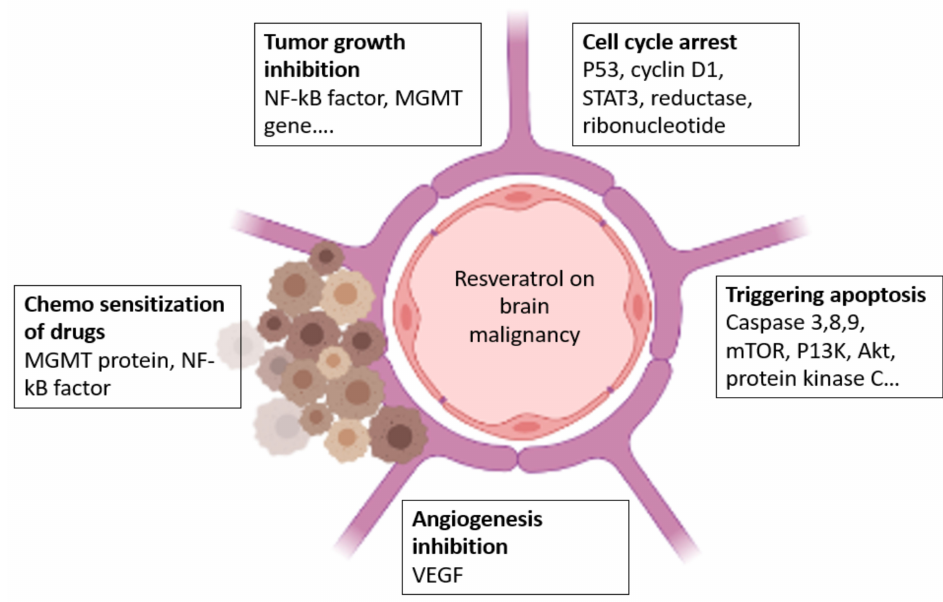
Figure 4. Effect of resveratrol on